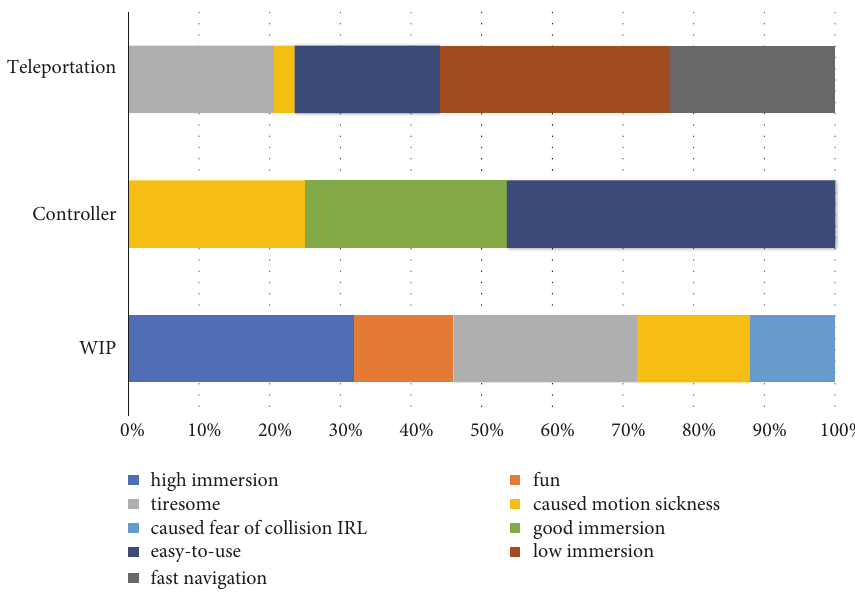
Figure 8: A summary of the VR locomotion techniques’ qualities based on the participants’ interviews.